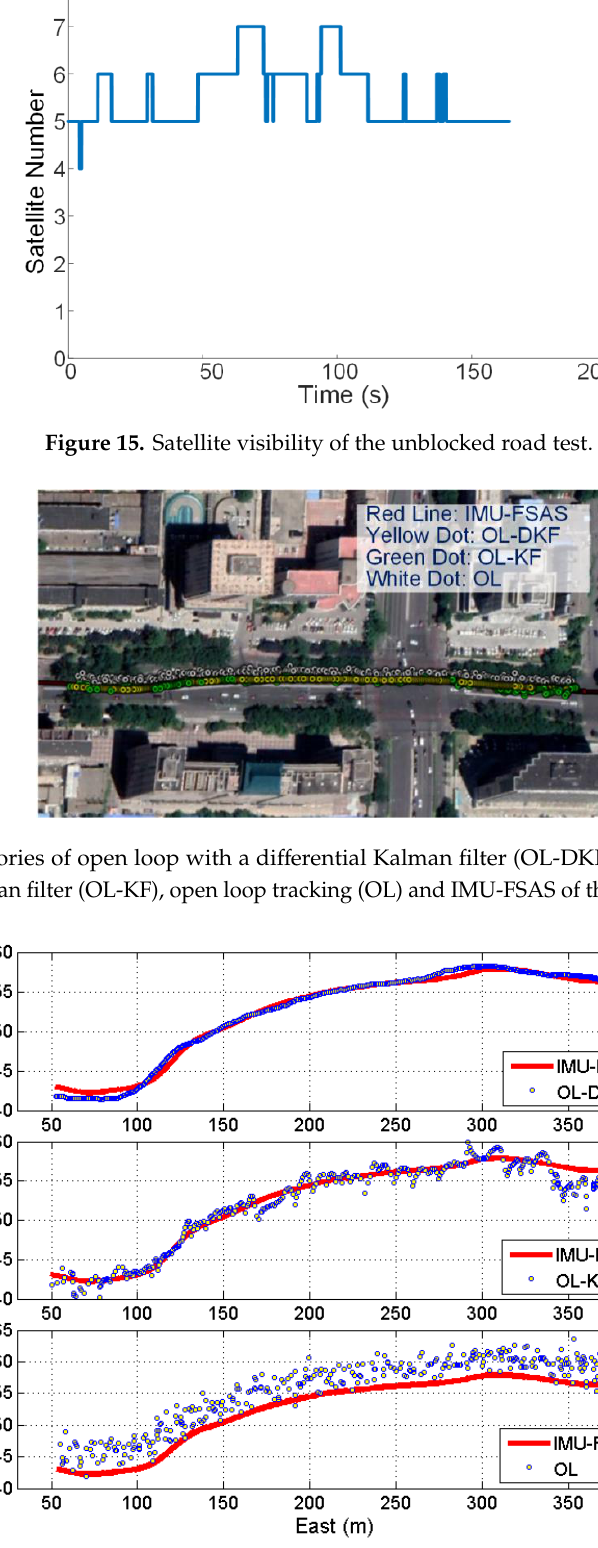
Figure 17. Position plot of OL-DKF, OL-KF and OL against IMU-FSAS of the unblocked road test.